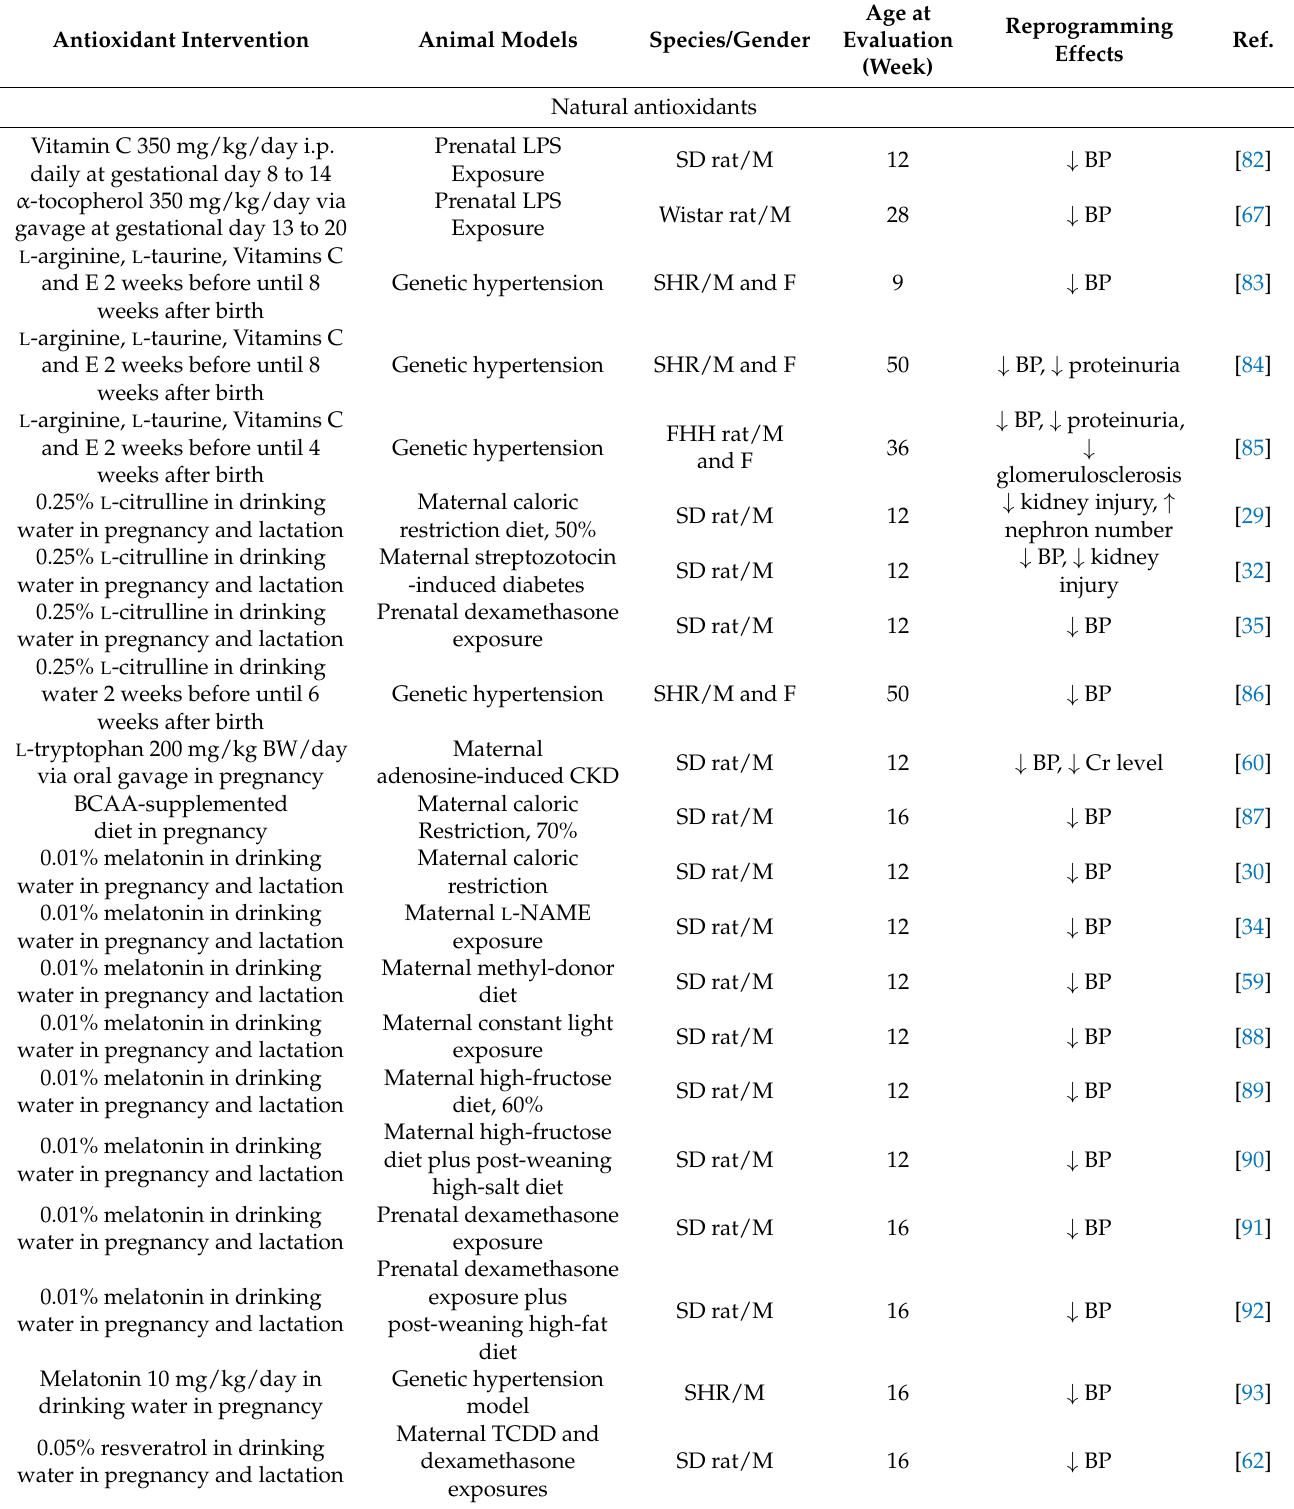
Table 2. Summary of antioxidants used as reprogramming interventions in animal models of renal programming.